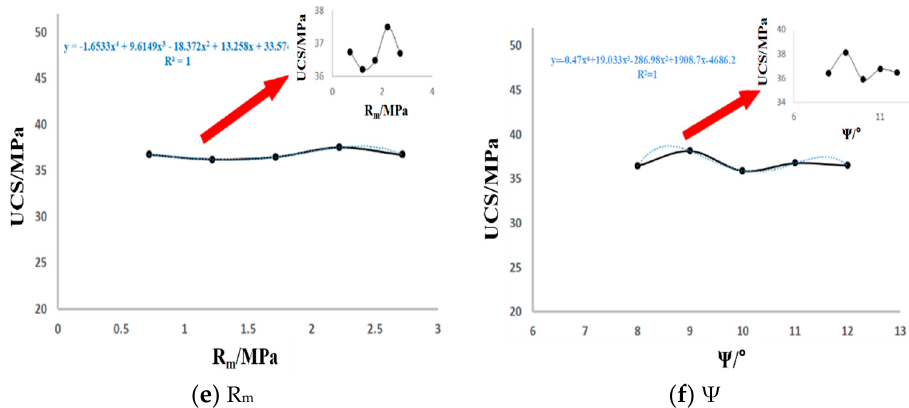
Figure 12. Effect of various parameters on changes in rock compressive strength. Figure 12. E ff ect of various parameters on changes in rock compressive